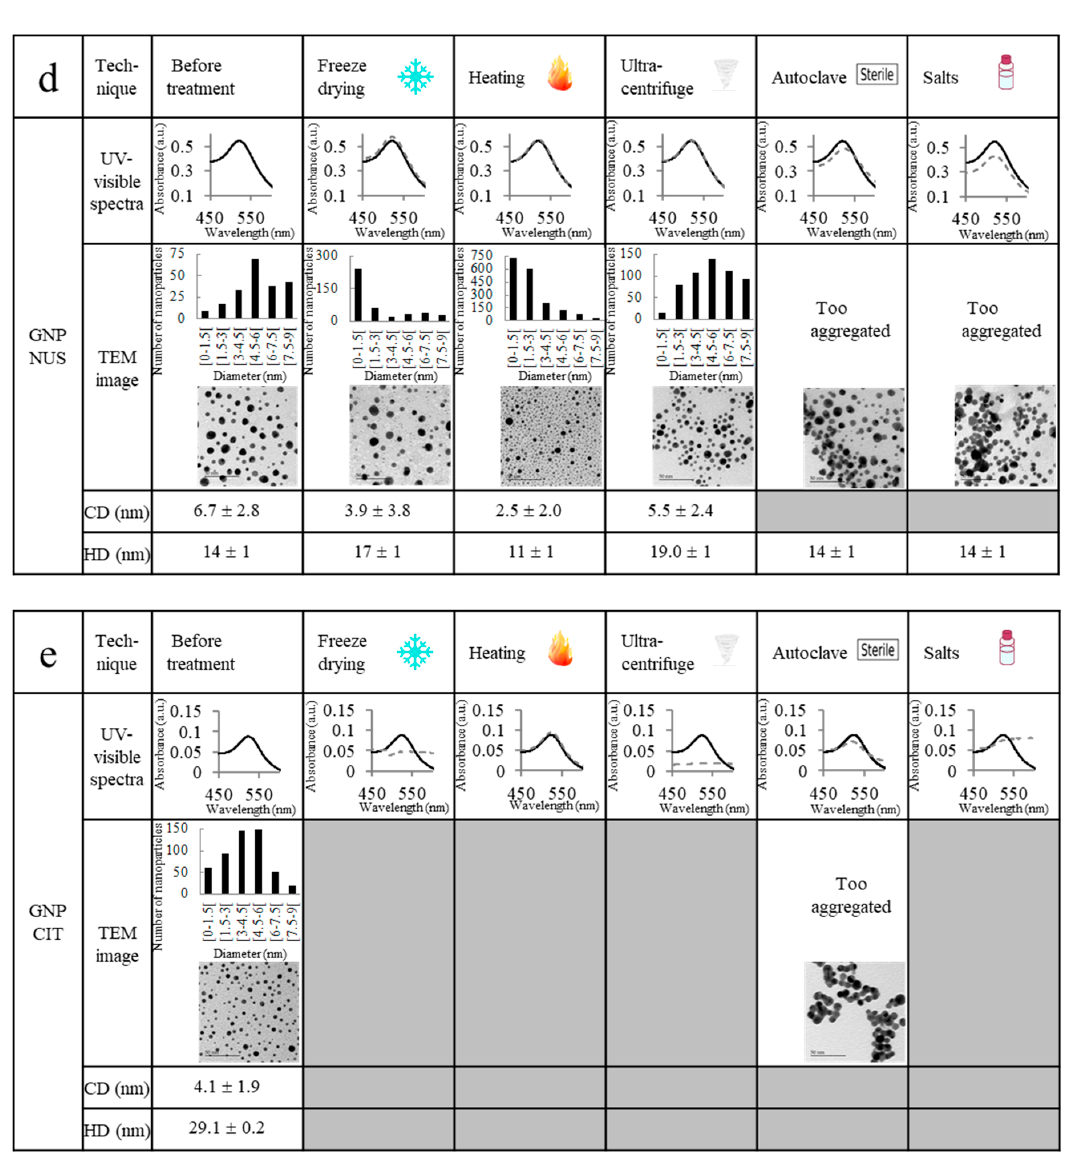
Figure 1. Ultrastability characterization of GNP 800 ( a ), GNP 2000 ( b ), GNP 6000 ( c ), GNP NUS ( d ) and GNP CIT ( e ) before treatment and after three cycles of 24h freeze drying, three periods of 12h of heating at 65 °C, three precipitations by ultracentrifugation, sterilization by autoclave, and suspension in PBS for a week. The UV-visible spectra of the GNP before and after the different treatments are represented by solid black lines and dashed gray lines, respectively. Core diameter (CD) and Hydrodynamic Diameter (HD) were obtained from TEM images and DLS, respectively. Experimental details are provided in the Materials and Methods section.